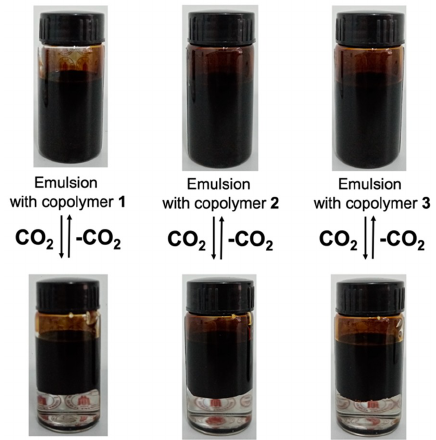
Figure 6. Reversible stability of crude oil emulsions and aqueous solutions. The aqueous solutions